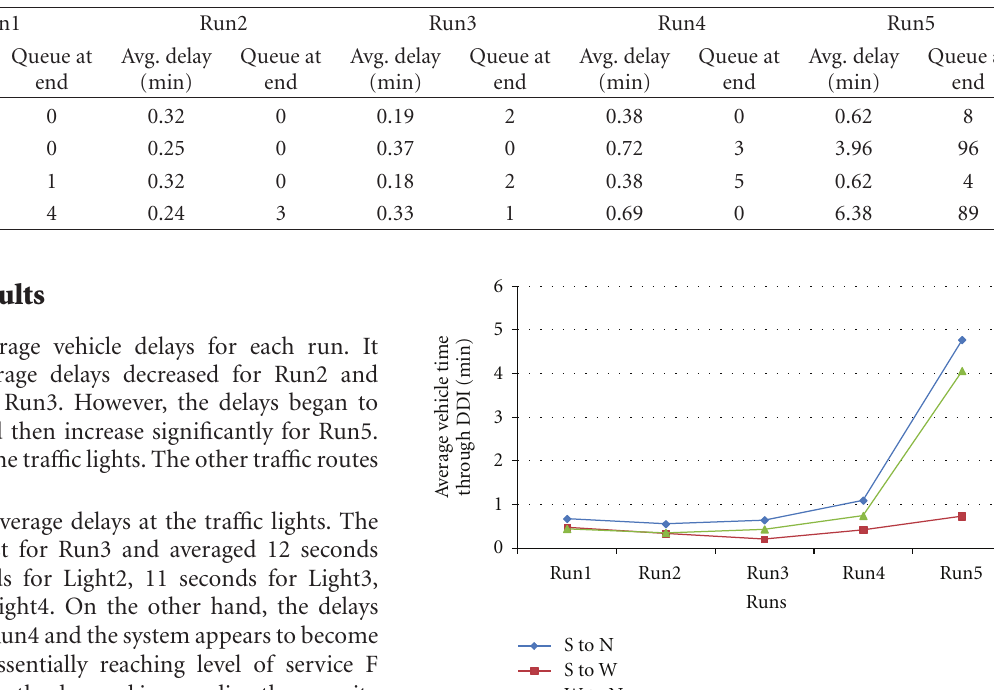
Table 6: Results for Runs2–5—average delays at tra ffi c lights.